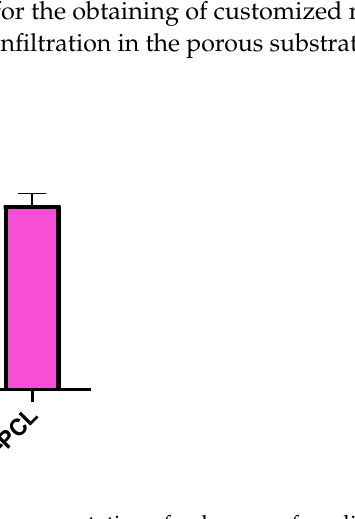
Figure 5. Graphical representation of volume-surface diameters (d vs ) of aRB-PCL and bRB-PCL.